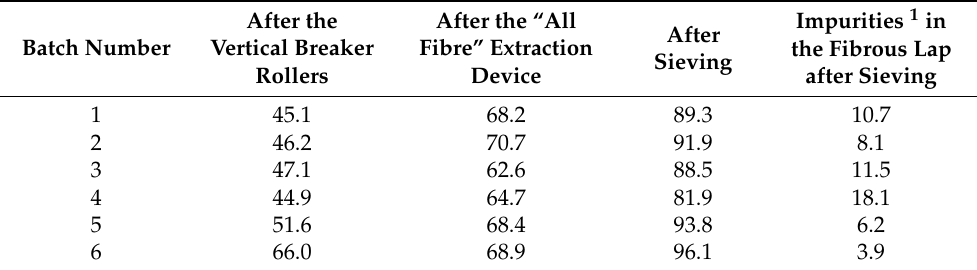
Table 6. Purity of the fibrous materials in fibres during process B (i.e., after the vertical breaker rollers, for the fibre lap at the outlet of the “all fibre” extraction device, and after sieving), and amount of impurities in the fibrous lap after sieving (% in weight). After the “All After the Impurities 1 in After Fibre” Extraction Batch Number Vertical Breaker the Fibrous Lap Sieving Device Rollers after Sieving 1 45.1